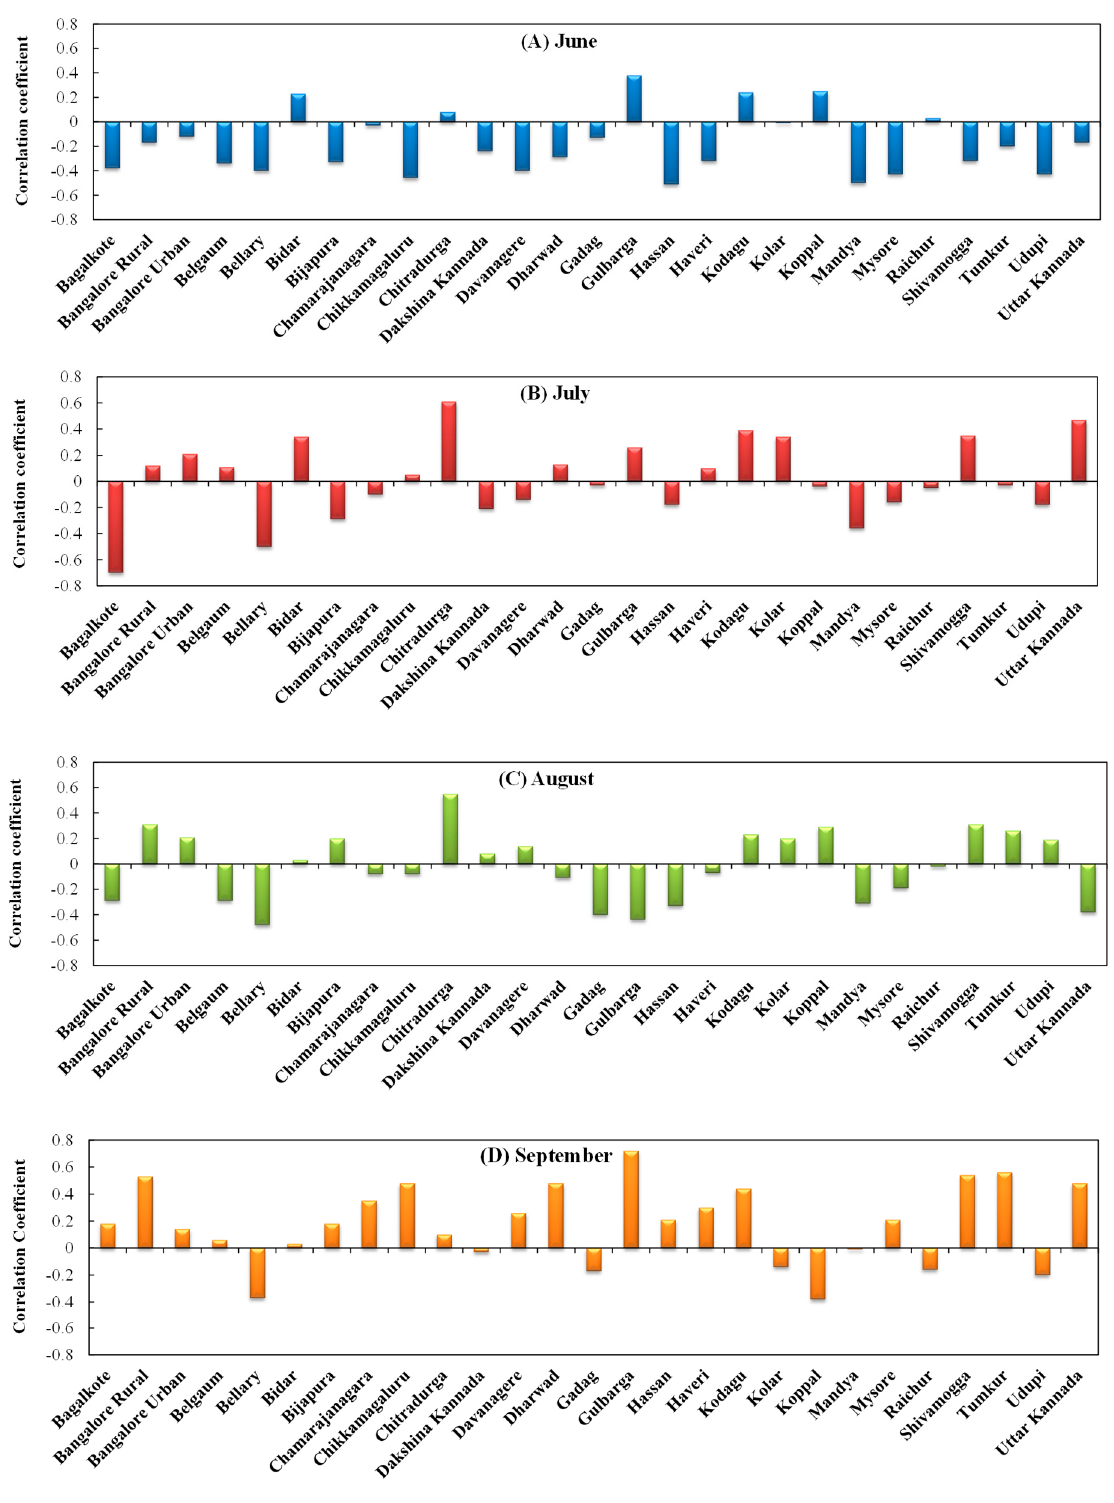
Figure 5. Correlation coefficient between Kharif rice productivity and ( A ) June, ( B ) July, ( C ) August, and ( D ) September months’ rainfall in different districts of Karnataka.